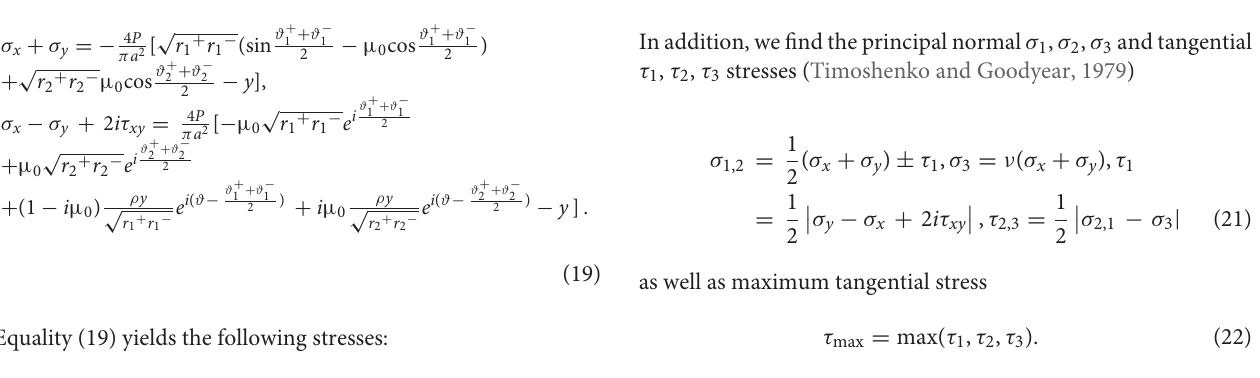
0.25, ν 0.3, Q / P 0.05, 0.1, 0.15, 0.2, 0.25). = = =